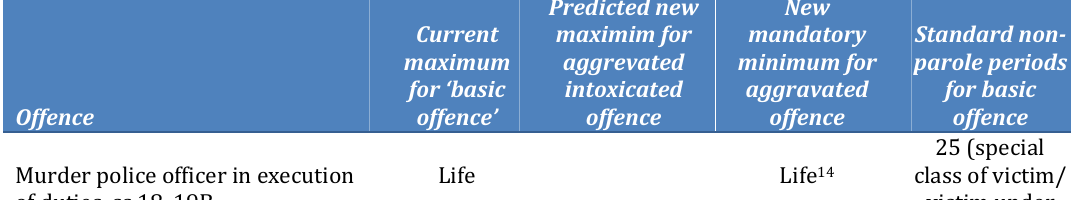
Current maximum for ‘basic